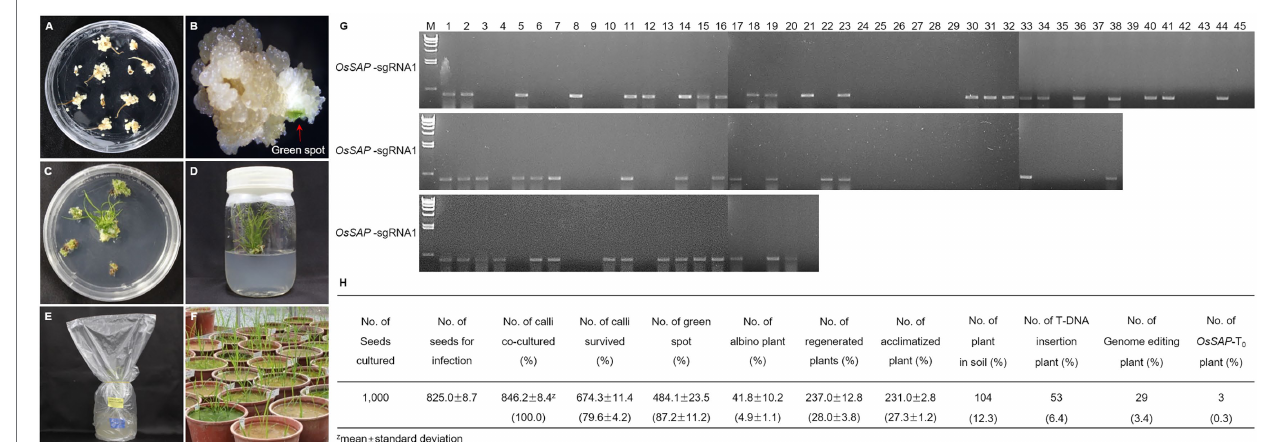
FIGURE 2 | Tissue culture system for development of OsSAP genome-editing rice. (A) When selecting seeds that induced callus, the seeds were clean and uncontaminated. After 21 days, callus was used for inoculation. (B) Agrobacterium was used to inoculate the callus and green spots formed in the regeneration media after 7 days. (C) Shoots from the green spot and a regenerated plant developed after 45 days in regeneration medium. (D) Shooting callus is transferred to new regeneration media for rooting for 30 days. (E) To acclimatize the regenerated plants, the lid of the medium was opened and covered with a plastic bag for 3 days. (F) After acclimatization, regeneration plants were transplanted into soil. After 90 days the T 1 seed can be harvested. (G) To analyze T-DNA insertion in regenerated plants, PCR amplification was performed using a hygromycin primer set. The hygromycin sequence was amplified in regeneration plants. The amplified products were loaded on 0.8% agarose gel. M: λ / Hin d III size marker, Numeric: number of regenerated plants. (H) Plant regeneration of the OsSAP genome-editing